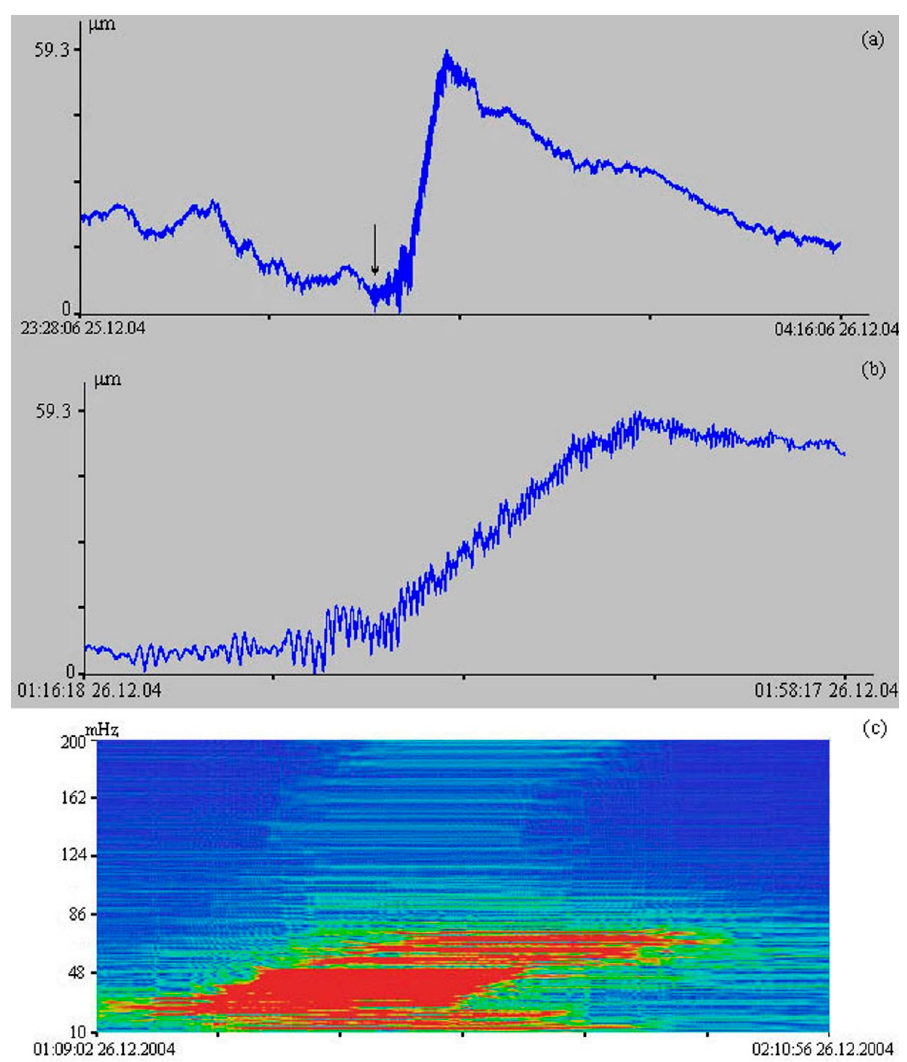
Figure 2. Fragment of the 52.5 m laser strainmeter recording from December 2004 ( a ), enlarged fragment of the laser strainmeter recording ( b ), and dynamic spectrogram of the laser strainmeter recording ( c ). Universal time is shown on the abscissa axis.